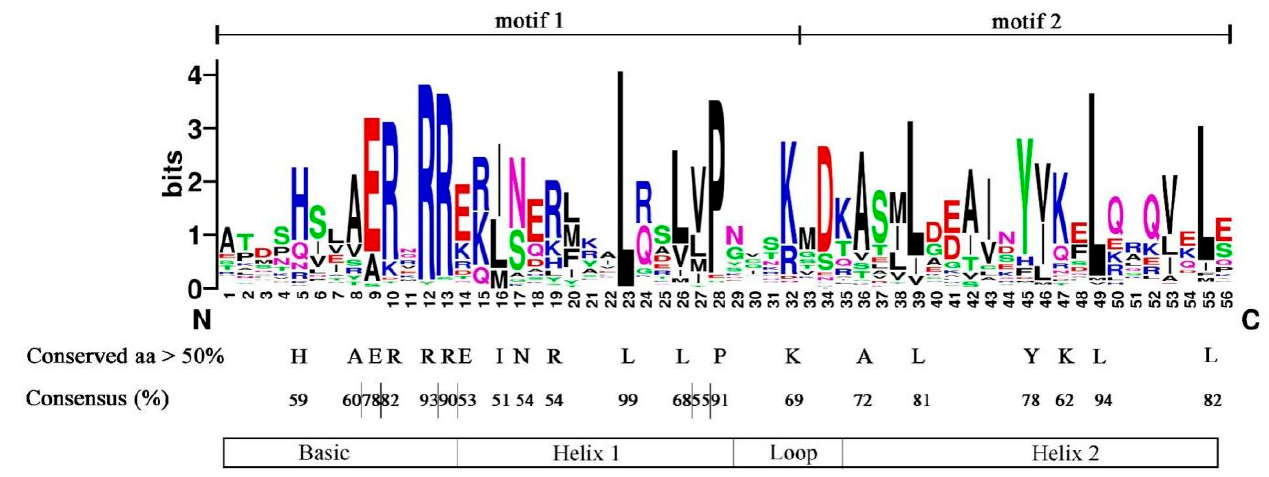
Figure 3. The bHLH domain of CebHLHs, consisting of motif 1 and motif 2.